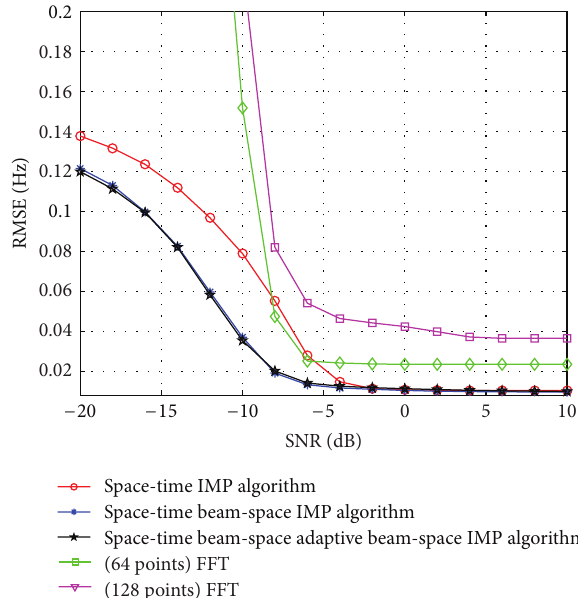
Figure 1: Probability of source resolution versus SNR in Doppler domain.